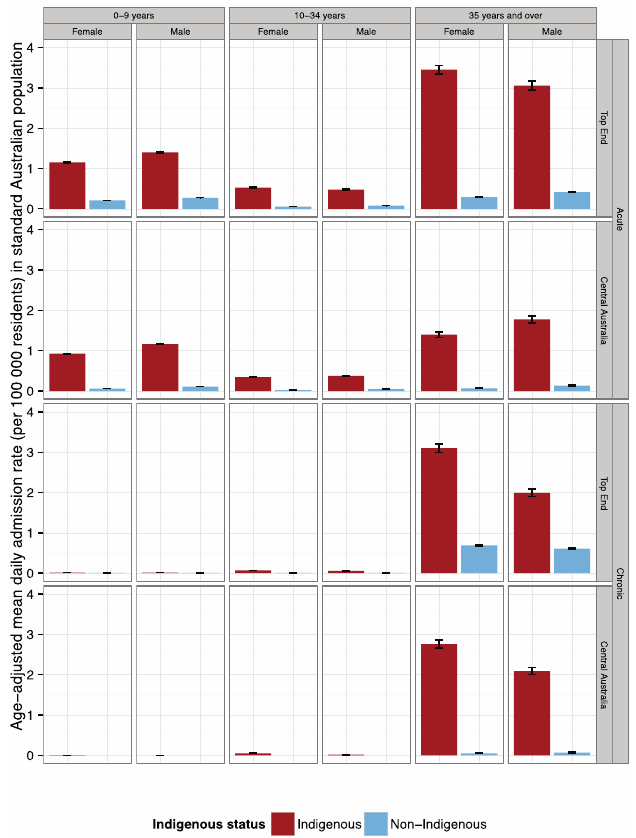
Figure 3. Age-adjusted daily admission rates, per 100 000 residents, for acute and chronic respiratory conditions, for the Top End climate zone and Central Australia climate zone by Indigenous/ non-Indigenous status, age and